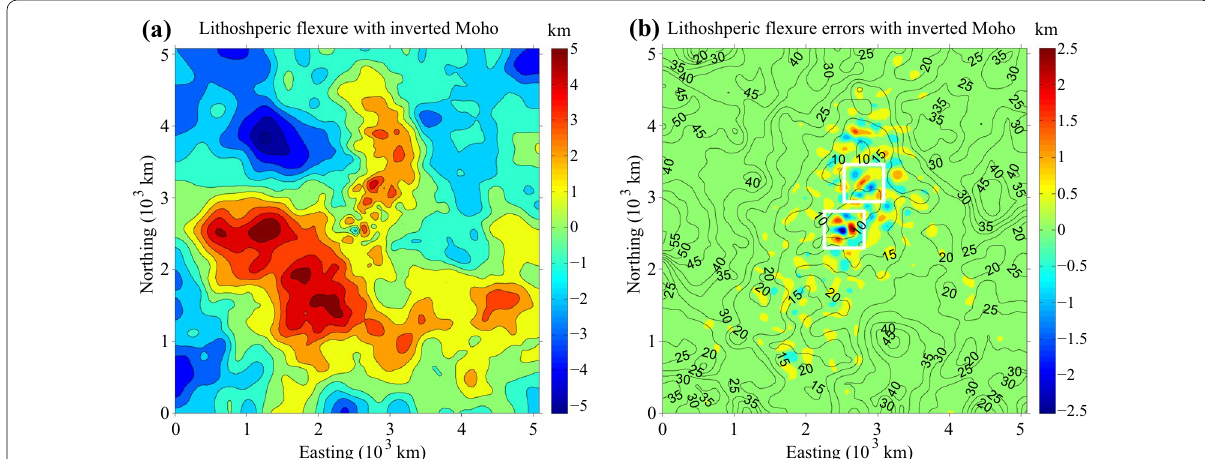
Fig. 11 a Lithospheric flexure using the inverted Moho values. b Base map is the lithospheric flexure errors for the model inversion using the inverted Moho values, the contours are from T